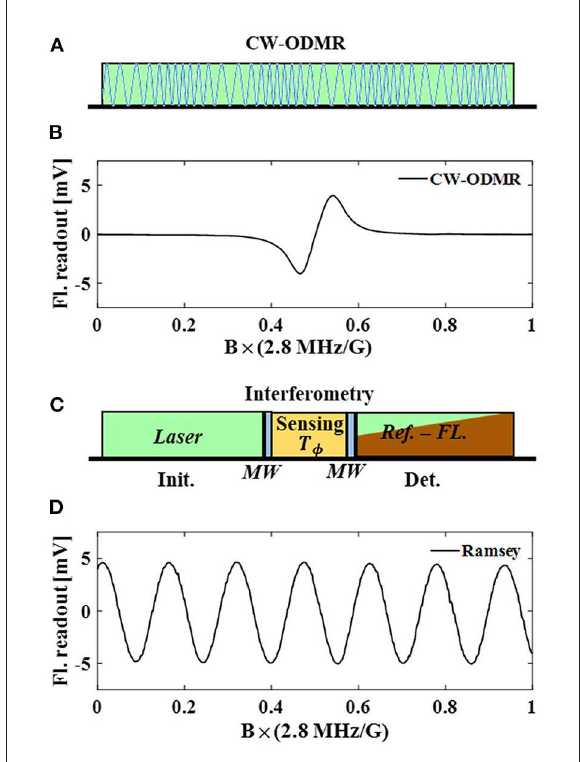
FIGURE2 (A) CW-ODMR method uses continuous wave laser pumping and MW field driving. The MW field is modulated in frequency or phase to get a modulated fluorescence signal. (B) CW-ODMR spectrum demodulated by the lock-in amplifier. MW frequency shift is used to simulate the line shift induced by an external field. B (2.8MHz / G) is used as the description of the horizontal × axis to show the relationship between the external field (in Gauss) and the line shift (in MHz). (C) Most of the interferometry methods consists of three parts, i.e., initialization, sensing, and detection. In the initialization part, a green laser (532 nm) is used to polarize spin states into m s 0, regardless of the = fluorescence emitted from the diamond. In the sensing part, the two blue blocks represent two MW pulses in a Ramsey sequence, and the yellow block depicts the magnetic field sensing time. The Ramsey sequence can be replaced by different interferometry sequences to measure dc/ac magnetic fields. In the detection part, fluorescences are collected to readout the spin population which indicates the spin-detected magnetic field information. The wedge red indicates that the fluorescence drops at the beginning of the detection window and continuously increases due to the repolarization induced by the detection-laser pulse. (D) The sensor response of Ramsey measurement to the MW frequency shift, which is equivalent to the response to the magnetic